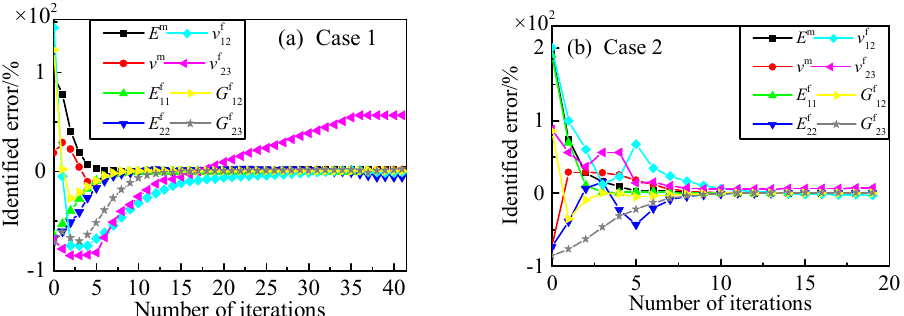
Figure 9. Constituent parameter identification with seven points using finite difference. ( a ) initial values: E m = 8 GPa, ν m = 0.45, E f11 = 100 GPa, E f22 = 6 GPa, ν f12 = 0.49, ν f23 = 0.1, G f12 = 60 GPa, G f23 = 2 GPa; ( b ) initial values: E m = 12 GPa, ν m = 0.1, E f11 = 800 GPa, E f22 = 5 GPa, ν f12 = 0.6, ν f23 = 0.6, G f12 = 50 GPa, G f23 = 1 GPa.